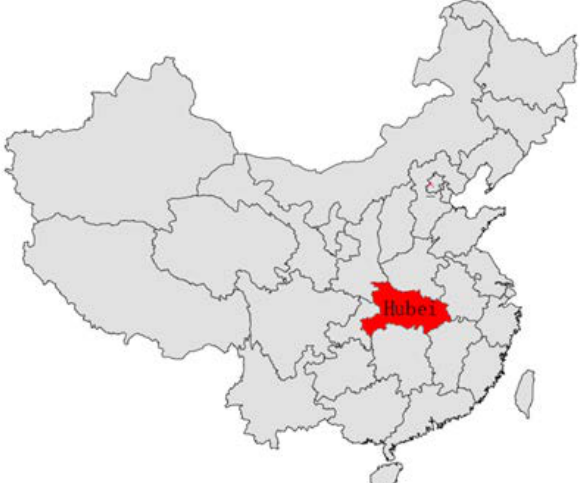
Figure 1 The location of Hubei in China